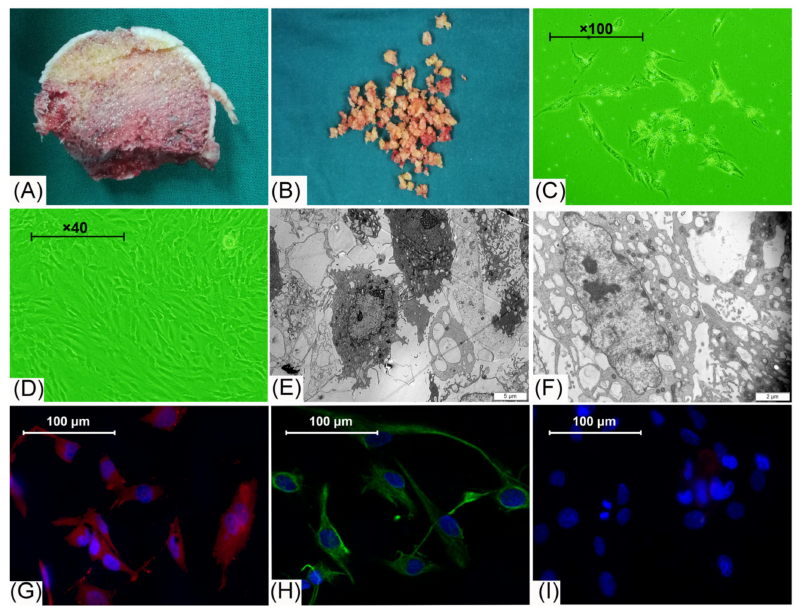
Figure 1. Obtaining of tissue sample, cell morphology observation, and purity identification. ( A ) Longitudinal section of the femoral head after femoral neck fracture; ( B ) bone particles for further isolation of cells; ( C ) three days after cell isolation, adherent cells evenly distributed in the bot- tom areas of the culture bottles, and were inconsistent in size and shape (100 × magnification); ( D ) isolated cells show cobblestone morphology after 7 days of culture (40 × magnification); ( E , F ) under scanning electron scope, cells were covered with microvilli and rich in organelles; ( G – I ) immunofluorescent staining shows high expression of CD31 ( G ) and vWF ( H ) and cells were negative for CD133 ( I ), red color indicates positive for CD31, green color indicates positive for vWF, and negative control images display cells stained with